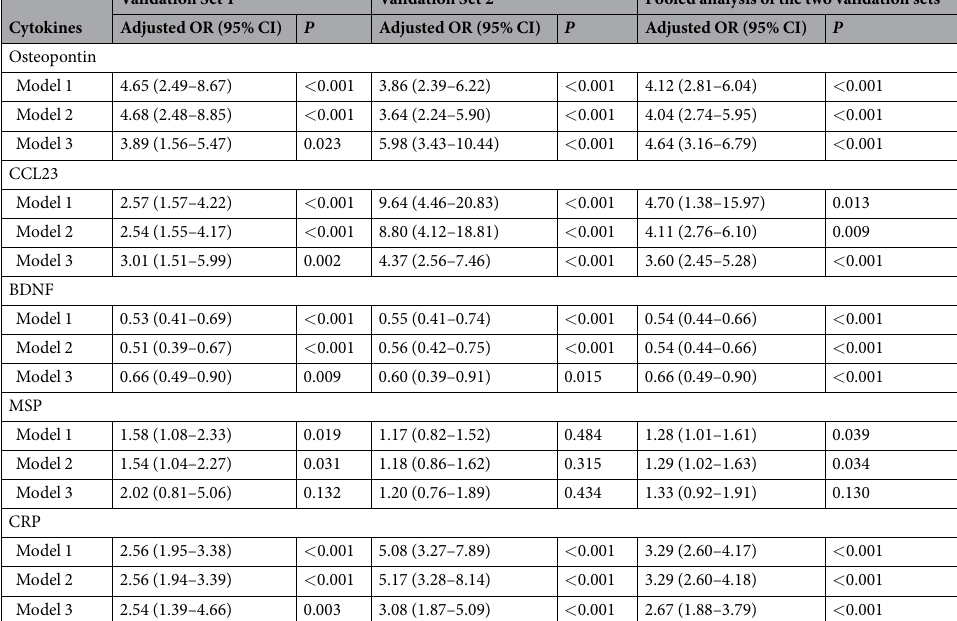
Figure 2 summarized the results of C-index, NRI, and IDI analysis in the nested case-control study. The C-index for incident ACS at 2 years of follow-up was increased from